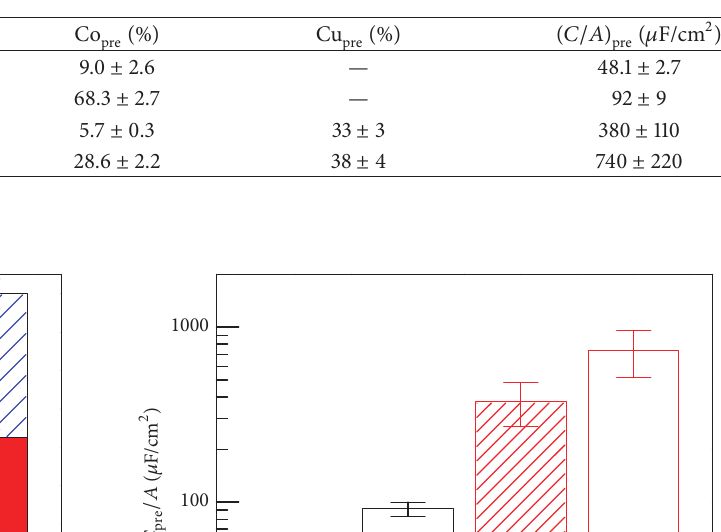
Table 1: The average as-deposited composition and specific capacitance results for all four sets of samples. The number of samples in each set, 𝑁 , is also listed. The uncertainties listed are the standard deviations of the results, representing the spread of results in nominally identical depositions. Note that the sum of the average compositions may not add up to exactly 100% due to the averaging procedure.